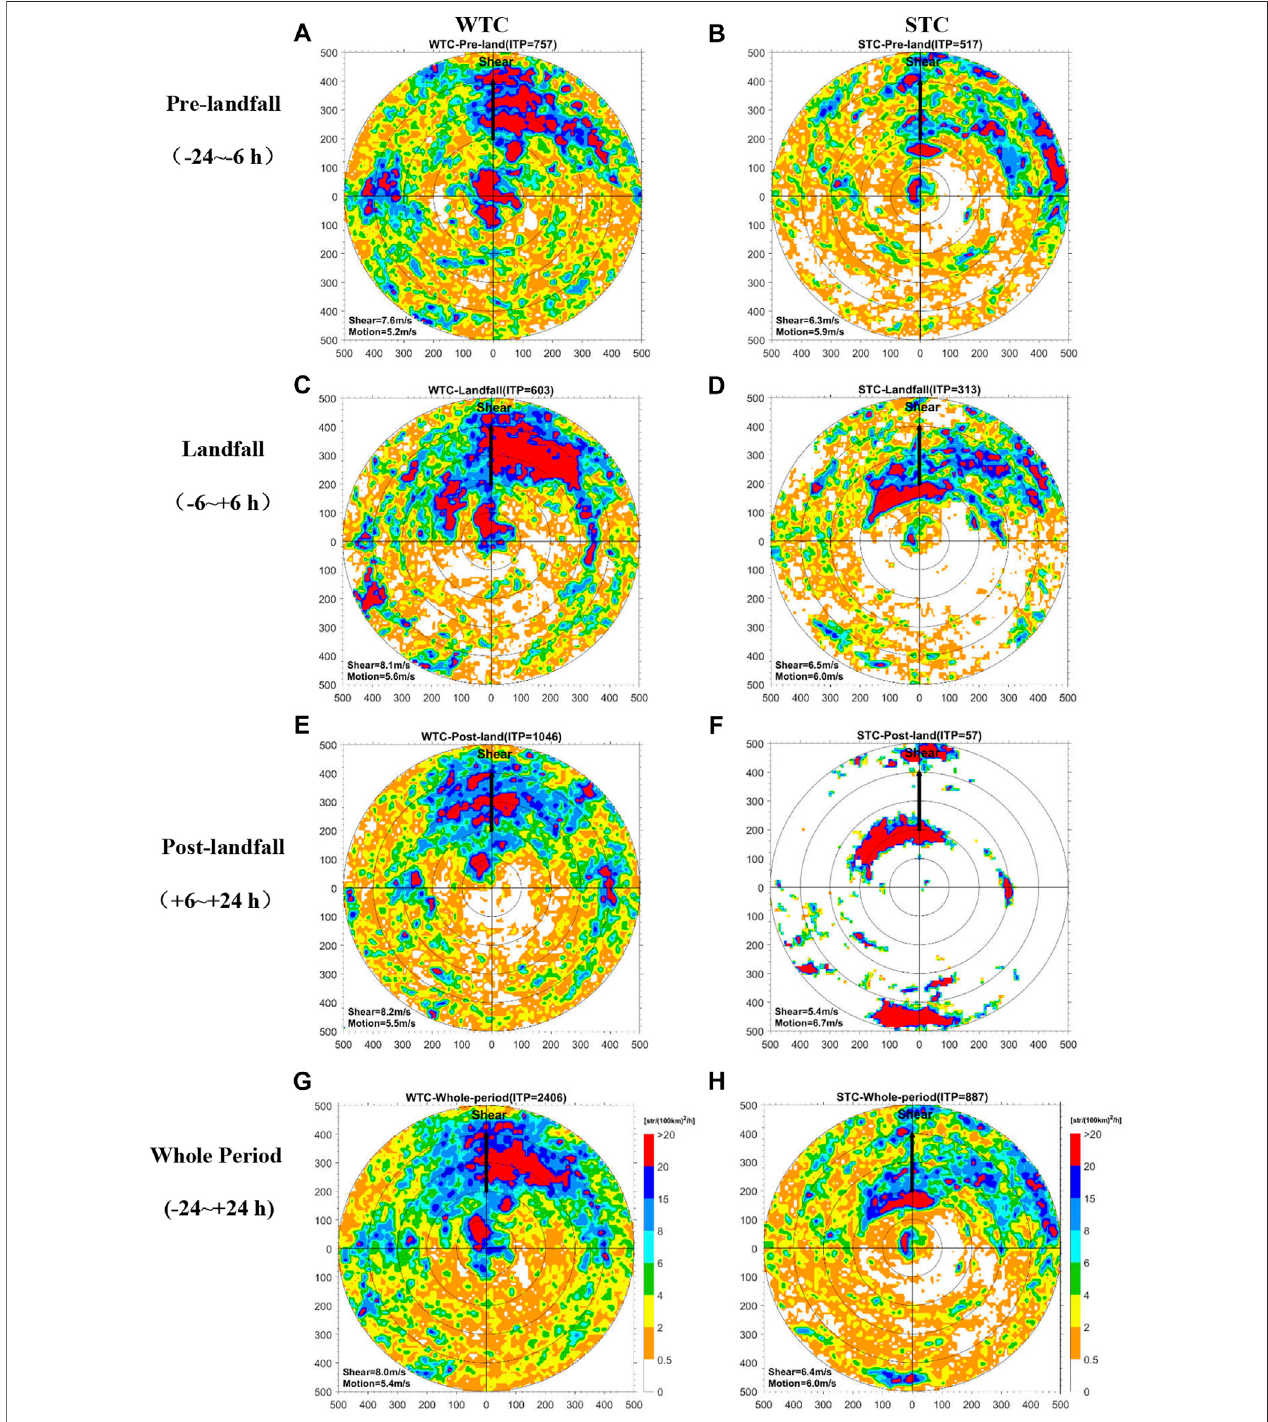
FIGURE9| Shear-related lightningdensity(str(100 km) − 2 h − 1 )asafunctionofstormintensityfor (A,B) pre-landfall( − 24~ − 6 h), (C,D) landfall(-6~+6 h), (E,F) post- landfall (+6~+24 h), and (G,H) the whole period ( − 24~+24 h). (A,C,E,G) Weak TCs, (B,D,F,H) Strong TCs.